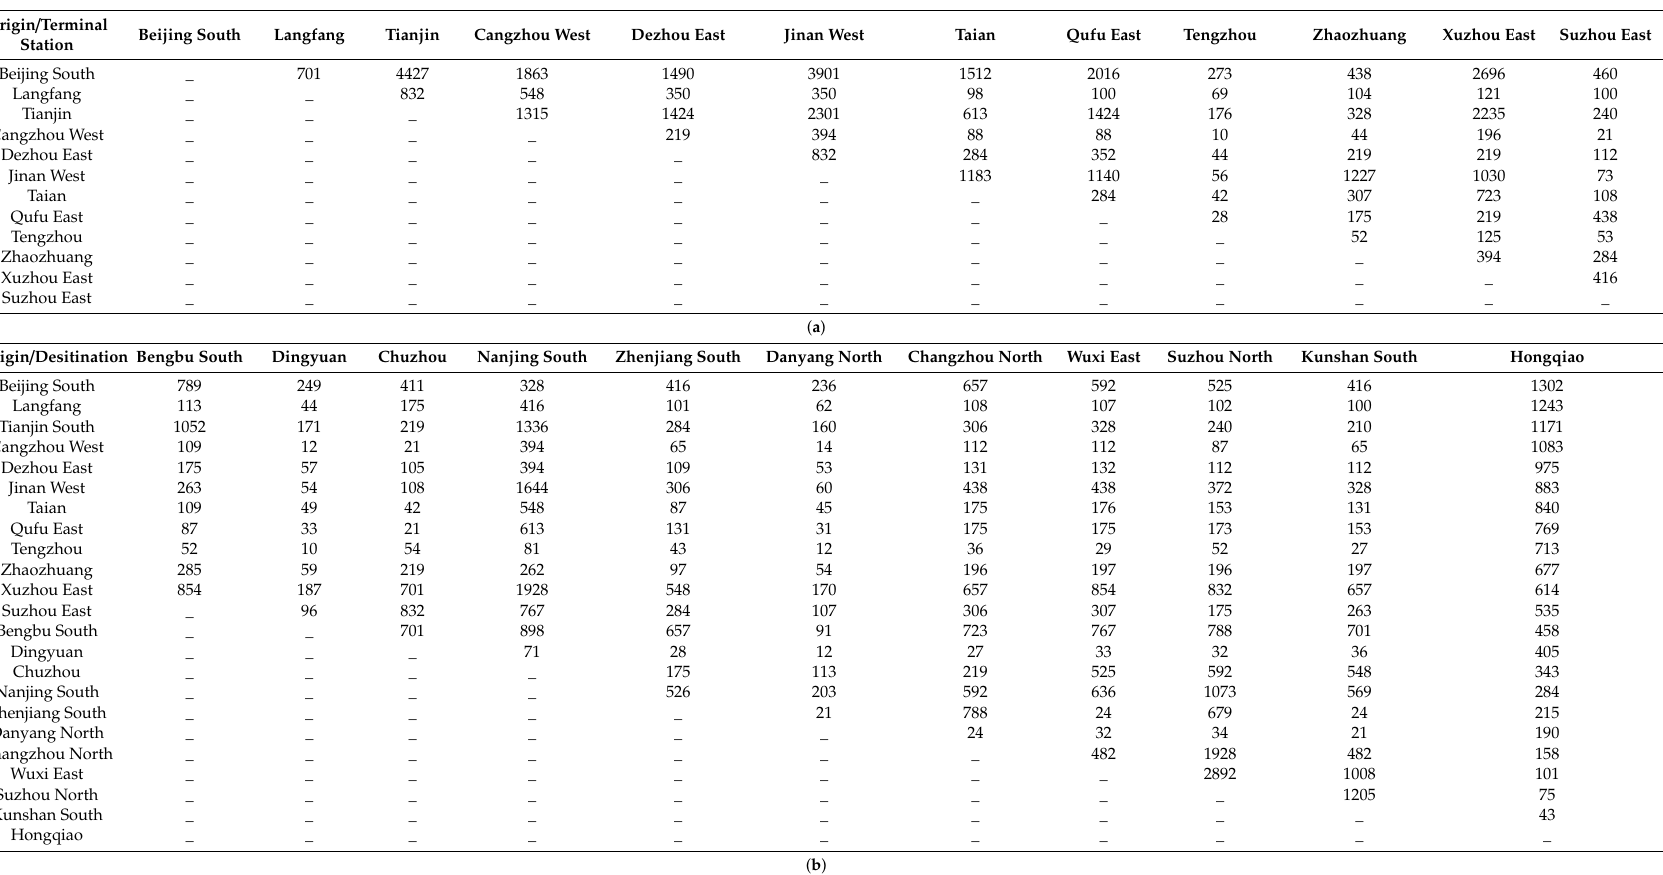
Table 12. ( a ) Passenger demand for each OD pair. ( b ) Passenger demand for each OD